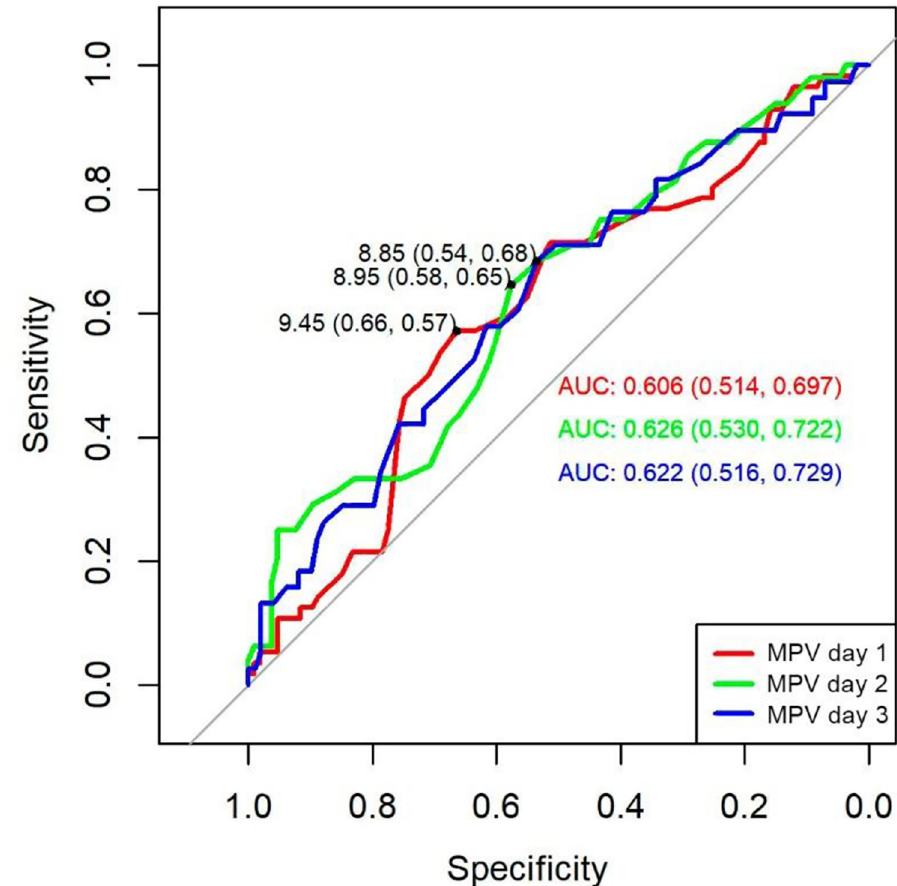
Fig 3. ROC curve of MPV to predict the risk of mortality in septic patients. AUC: area under the curve.